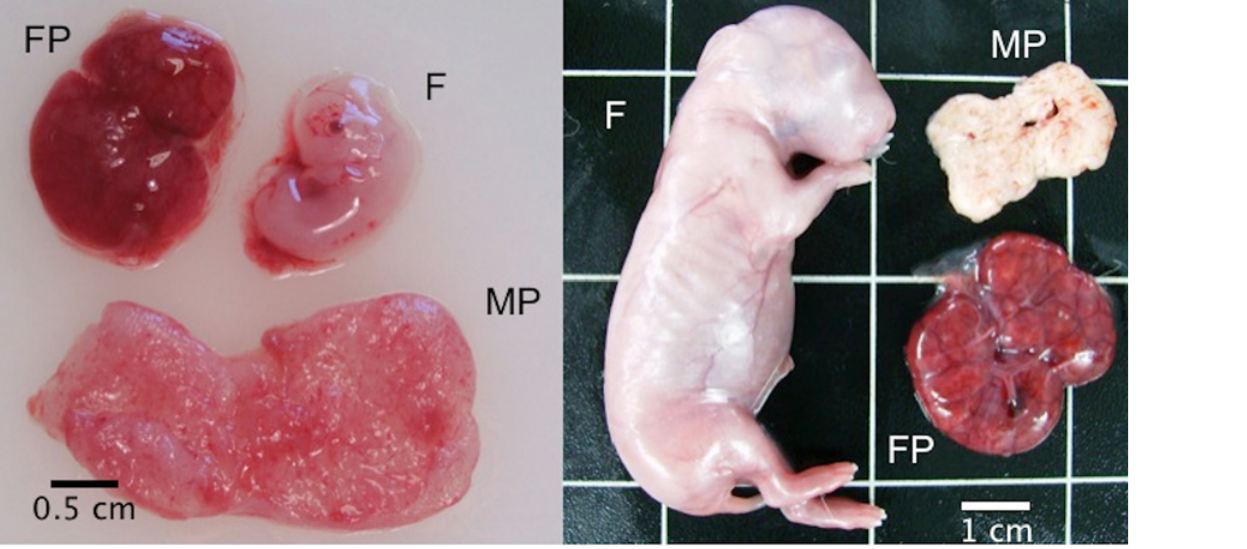
Fig 1. Rabbit foetus (F), foetal placenta (FP) and maternal placenta (MP) at Day 14 (left) and Day 24 (right) of gestation.